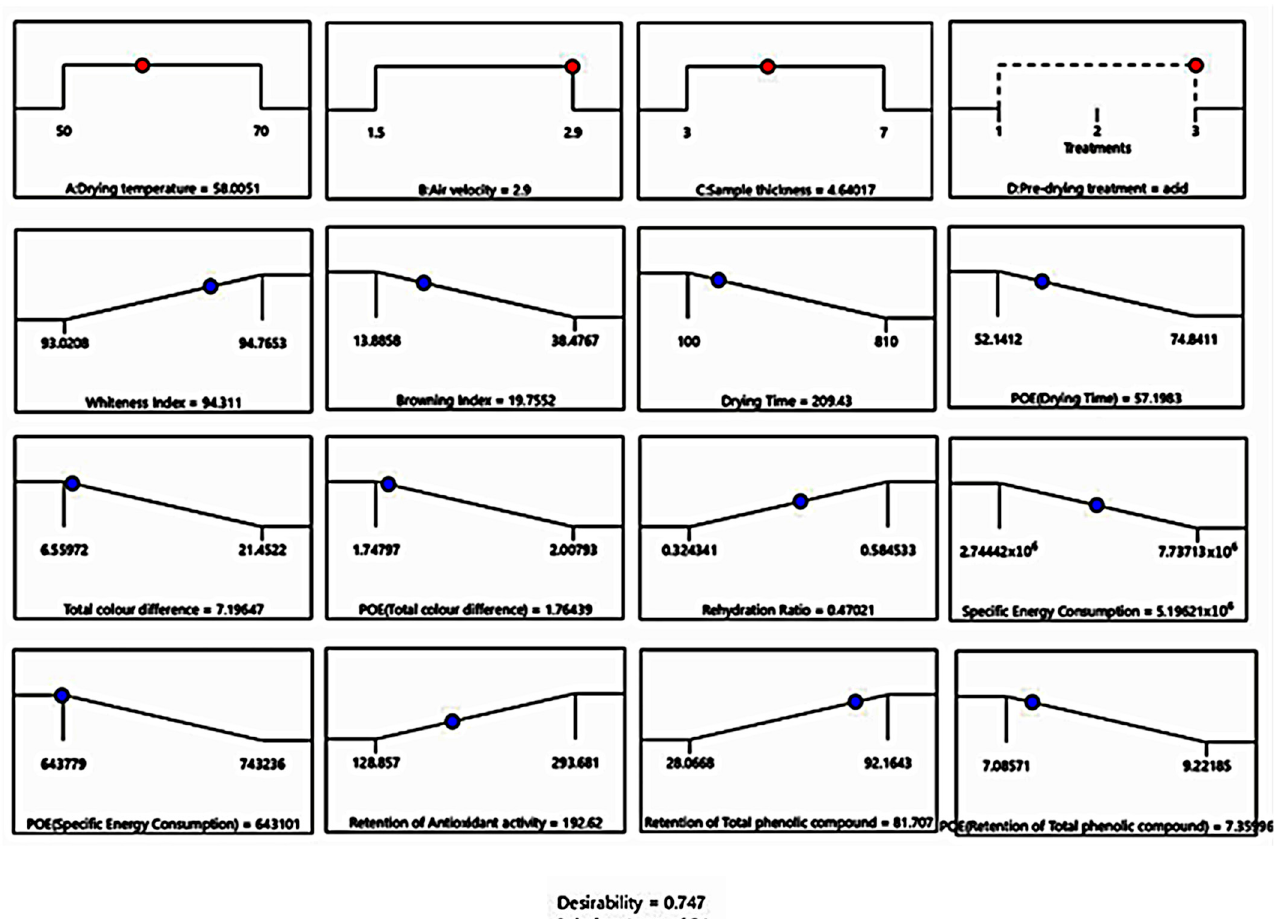
Figure 8. Numerical optimisation for quality and specific energy consumption of hot-dried celeriac slices.